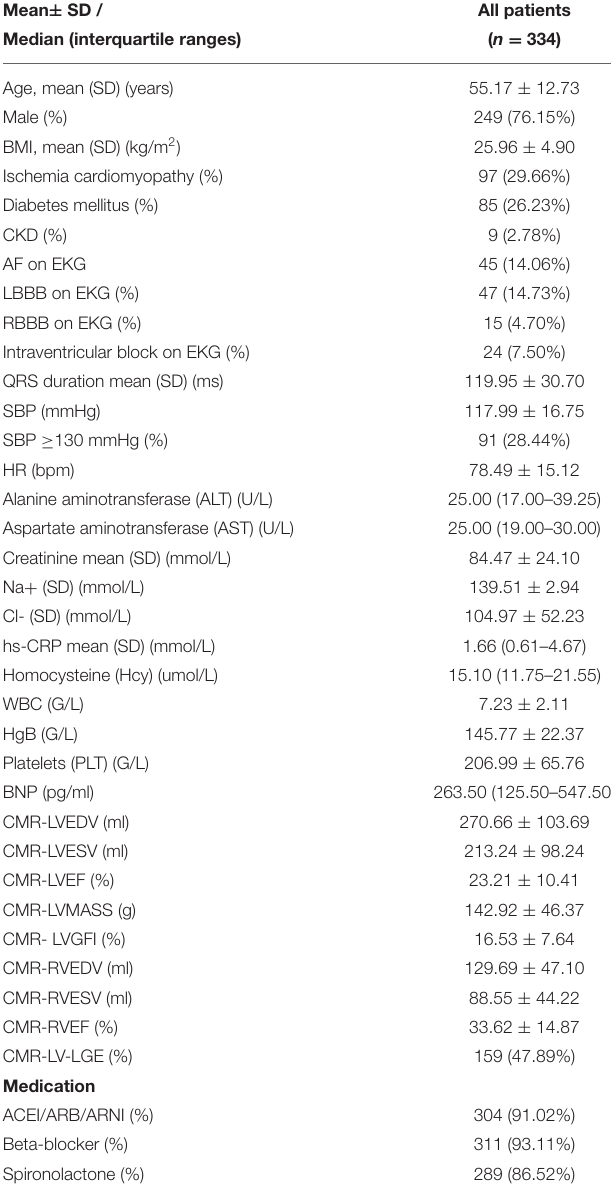
TABLE 1 | Baseline characteristics of patients with